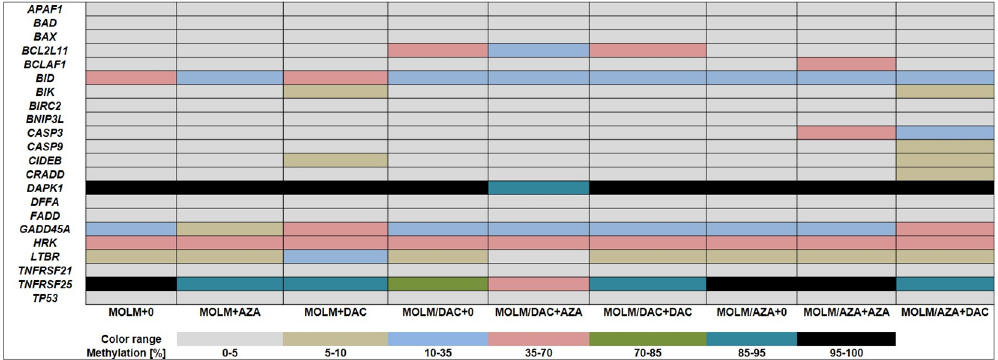
Figure 5. DNA methylation level in apoptosis-associated genes in the sensitive MOLM-13 cell line and resistant MOLM-13/AZA and MOLM-13/DAC variant cell sublines. The Cells were incubated for 72 h in growth medium in the absence (0) or presence of AZA (1 μM) or DAC (1 μM) in a CO 2 incubator. The cells were treated with AZA or DAC every 24 h. Table 1. Genes for which methylation was detected by the EpiTect ® Methyl II Signature PCR Array Kit. Gene